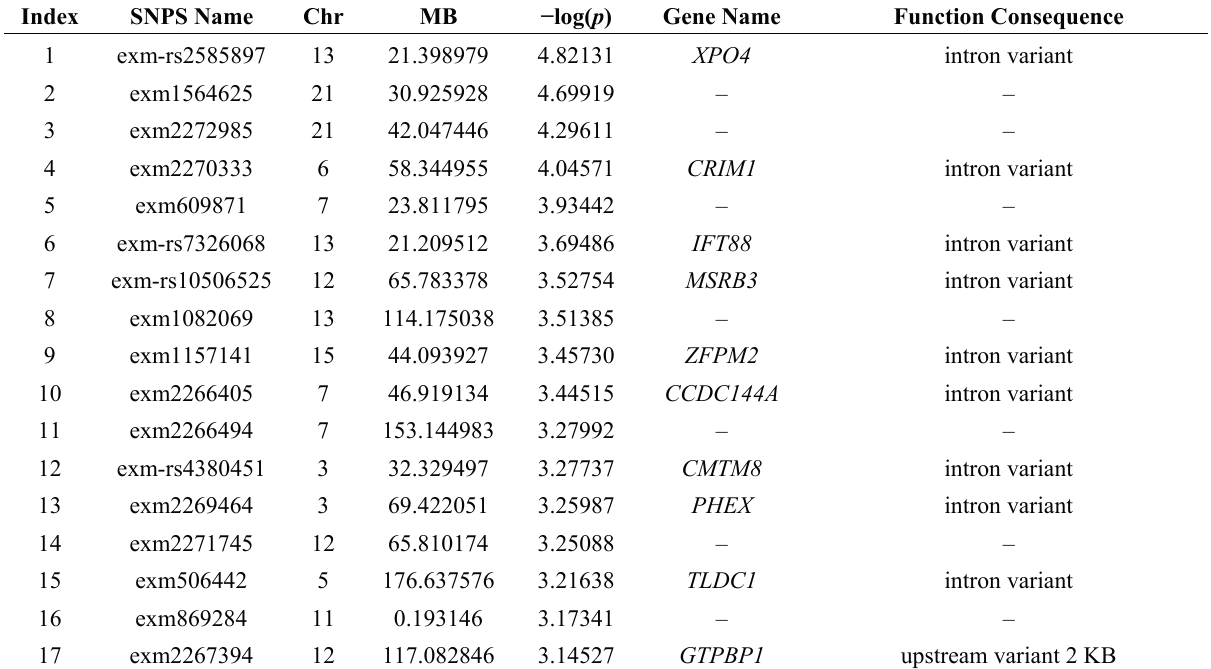
Figure 1. The expression quantitative trait loci (eQTL) that regulates the expression level of Collagen, type III, alpha-1 ( Col3a1 ). ( A ) eQTL on chromosome (Chr) 12 located between 99 MB (million bases) and 104 detected with probe 1724883; ( B ) eQTL located on Chr 12 region between 101.7 and 103.8 MB. Table 1. Candidate genes for eQTL of regulation of Col3a1 expression level in